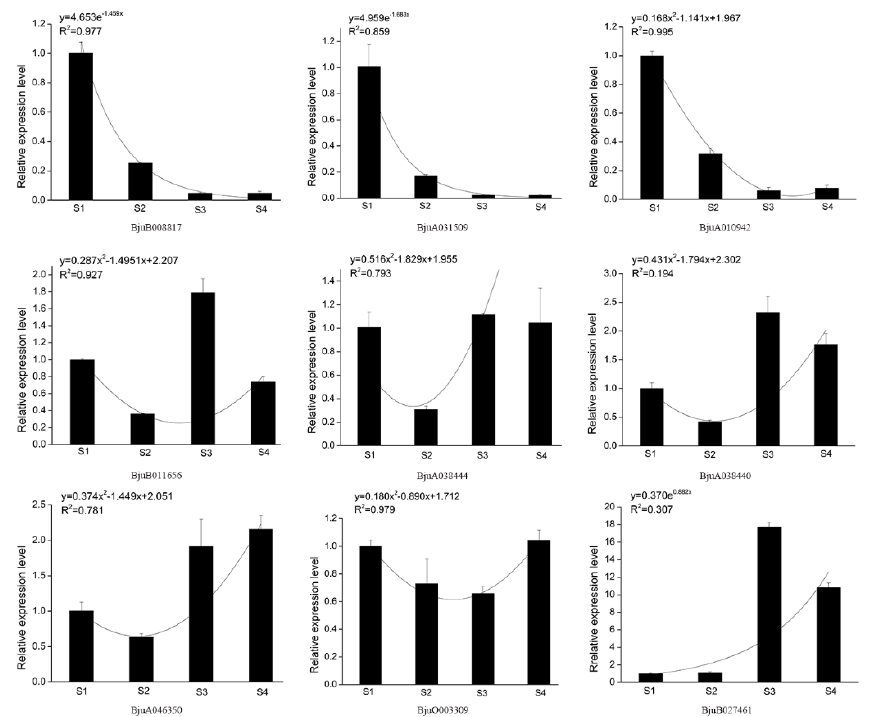
Figure 10. Gene expression and regression analysis of BjuXTH family genes.